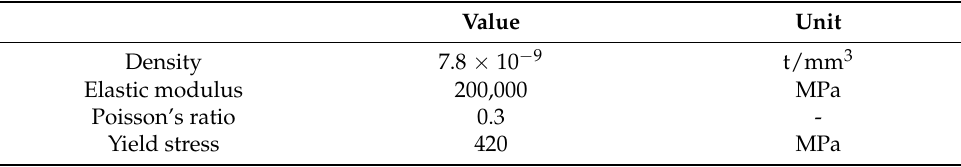
Table 4. The properties of steel tubes in the numerical model.